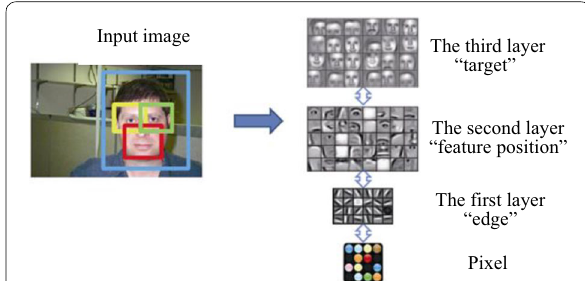
Figure 16 Layer-by-layer feature extraction results of a CNN applied to face recognition (source: